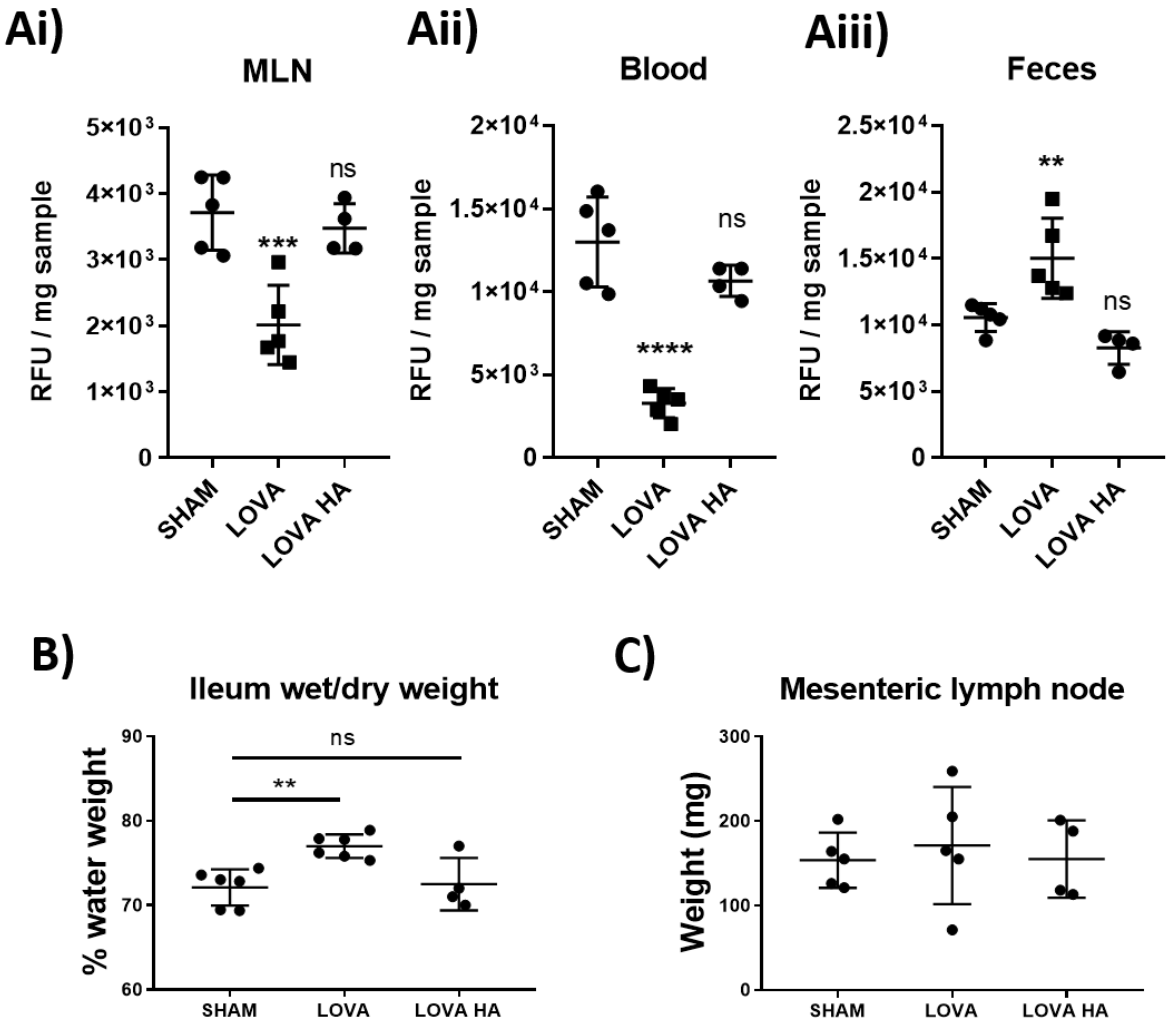
Figure 6. Pro-drug form of Lovastatin inhibits dietary lipid uptake in vivo. Rats were fasted for 4 h before treatment with a 10 mg/kg I.P. injection of either saline control, Lovastatin, or Lovastatin-hydroxyacid (HA) 1 h prior to being gavaged with a bolus of Bodipy-FL16 combined with oleic acid. 1 h after the bolus was given, ( Ai ) mesenteric lymph nodes (MLN), ( Aii ) blood, and ( Aiii ) feces were collected and analyzed for Bodipy content (see Methods). Additionally, fluid retention within the ( B ) ileum (ILE) and ( C ) MLNs were determined by wet/dry weight analysis. Data are presented as mean ± SEM of 5 rats over 5 independent experiments. ** p < 0.01, *** p < 0.001, **** p < 0.0001 vs. sham One-way ANOVA with Dunnet’s multiple comparison test. ns-not significant.